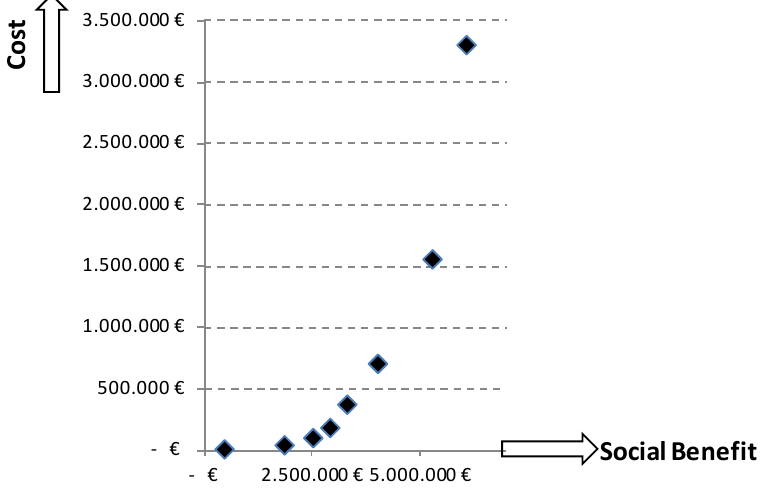
Figure 2. Graphical representation of some points of the benefit-cost curve of the best road safety measures for a case